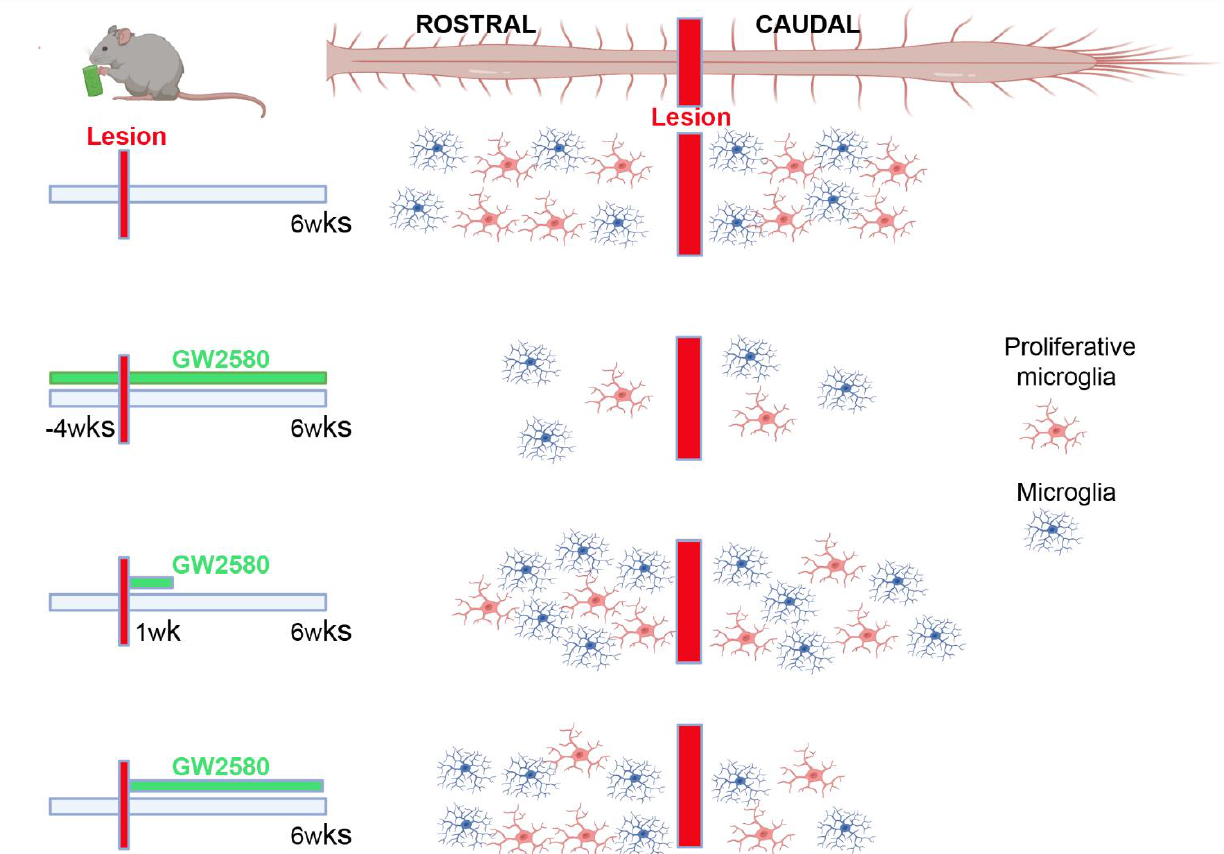
Figure 5. Microglia spinal distribution after injury depends on GW2580 treatment duration. Schematic drawings of the rostro–caudal distribution of microglia in the spinal cord 6 weeks after SCI. Microglia number and states are affected differently depending on the duration of GW2580 oral treatment. Homeostatic (blue) and proliferative (red) microglia distribution in the spinal cord after SCI without GW2580 treatment ( A ), after long-term pre- and post-SCI treatment ( B ), following short-term post-SCI treatment ( C ), and after long-term post-injury treatment ( D